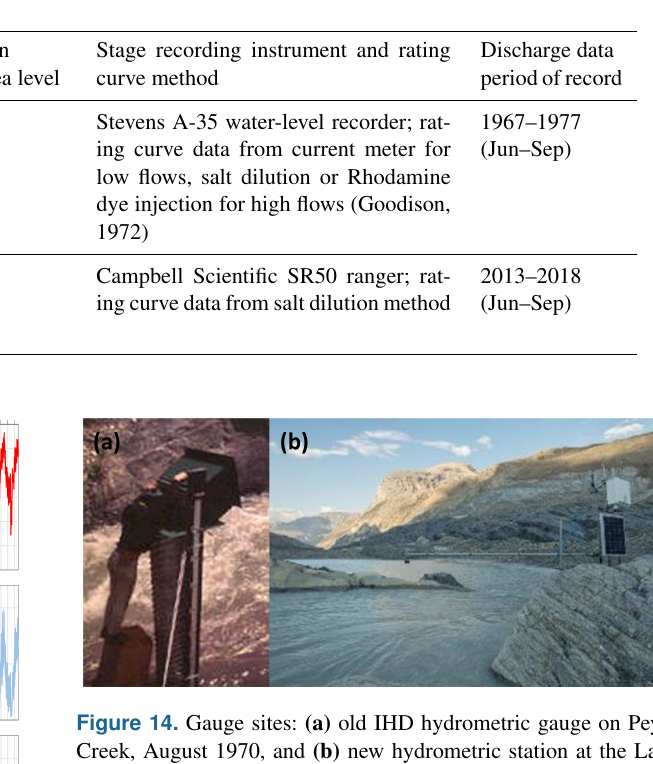
Table 6. Hydrometric station information.